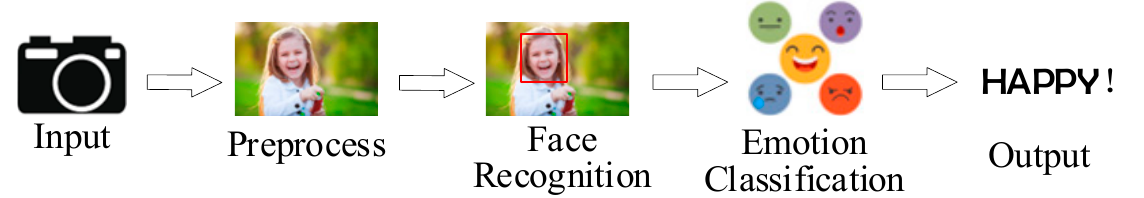
Figure 3. Facial expression recognition process.